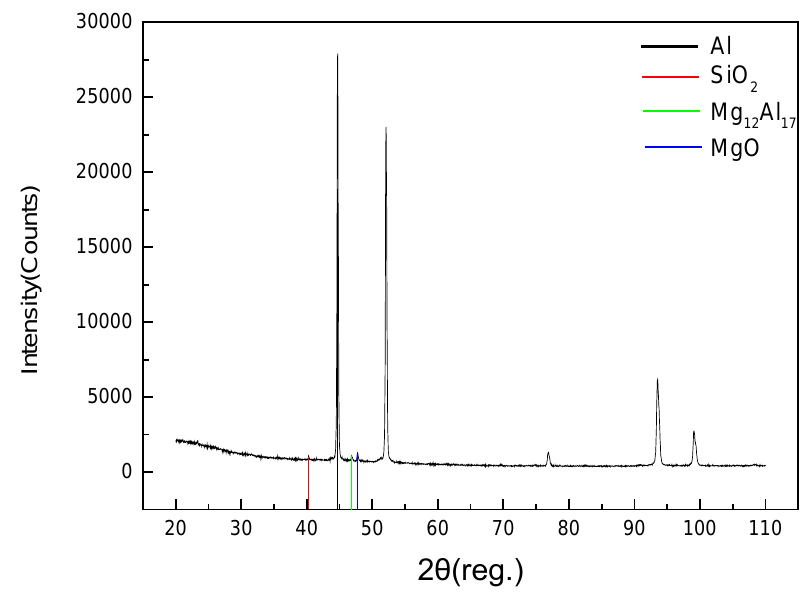
Figure 16. X-ray diffraction (XRD) patterns of specimens with synchronous water-cooling.